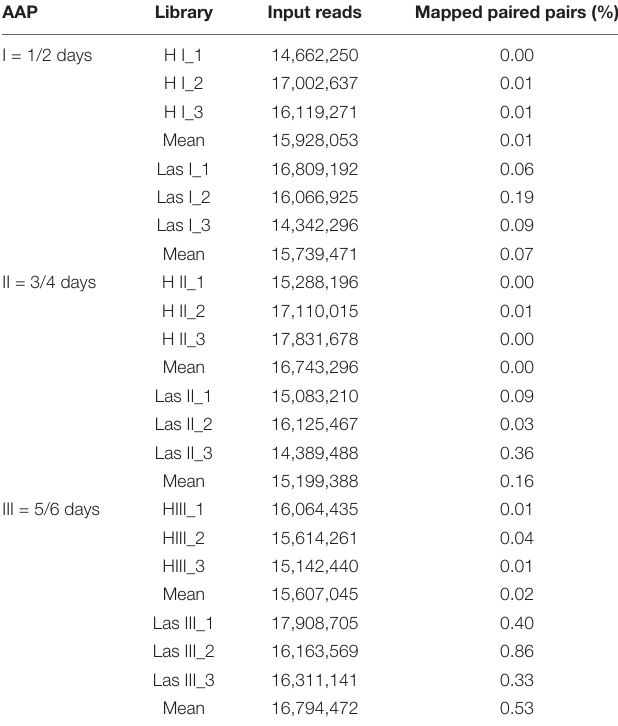
libraries. Besides these three genes, flp2 , flp3 , and flp7 were also mapped (B2I23_RS02390; RS02395 and RS02410). Reads